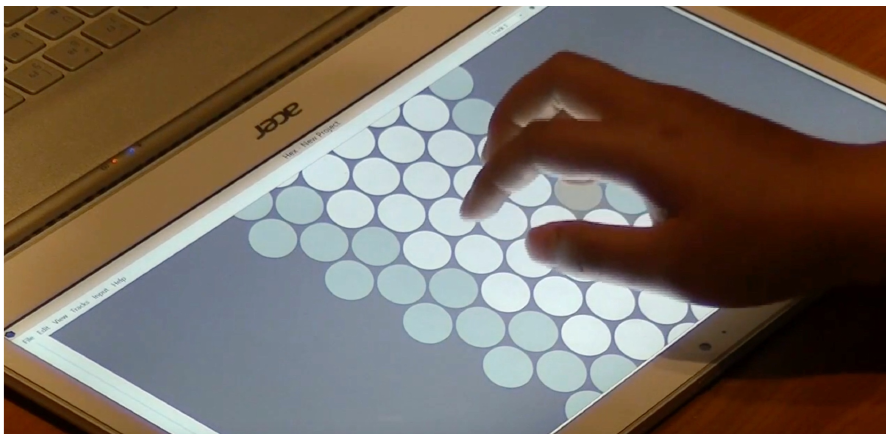
Figure 6. The multitouch interface used in the experiment.